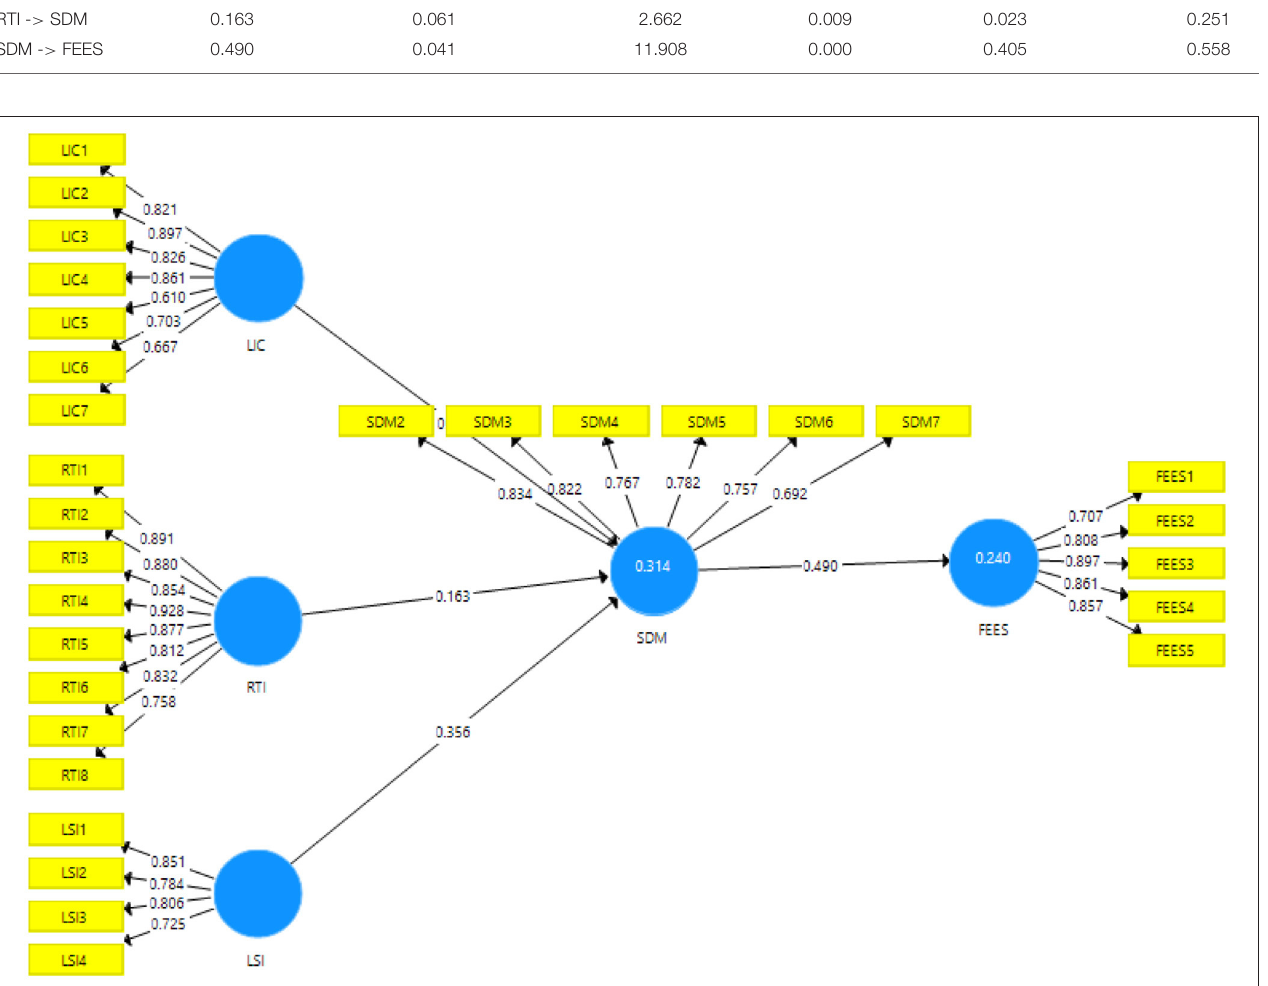
FIGURE 3 | Measurement model